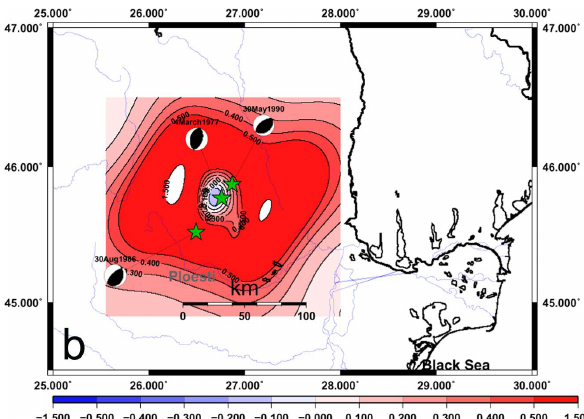
Fig. 2. Map of Coulomb stress due to the 1977 earthquake for optimally oriented faults to regional compression (N307 ◦ E) at the depth of 131km (hypocentral depth of the 1986 event) in the case of (a) effective friction 0.4 and (b) 1. Colour palette of stress values is linear in the range of − 0.5 to +0.5bar (1bar=100kPa). White colour indicates area where transferred stress > 1.5bar. Green stars show the earthquake epicentres.